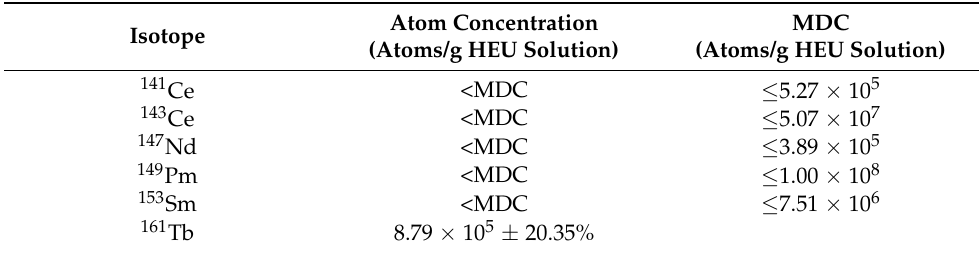
Table 6. LEPS results for the purified Tb fraction; each sample was counted up to 10 days. Samples were run in quadruplicate and uncertainty on atom concentration is 1 σ